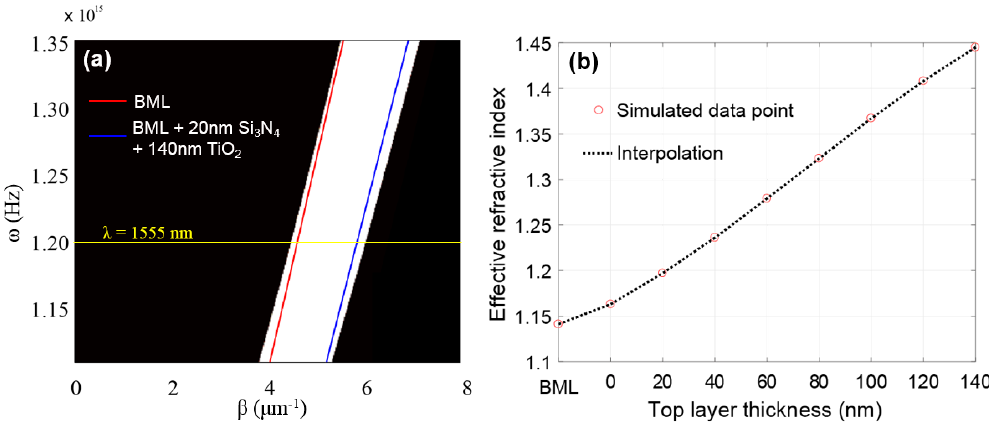
Figure 5. ( a ) Band-gap diagram and dispersion curves, obtained by TMM. The clear area is the localized photonic band-gap. The dispersion curve of the BML indicates the lowest effect index, n = 1.141 at λ = 1555 nm. Adding the defect layer and the top device layer moves the dispersion curve towards the right-side band edge, where the larger wavenumber indicates the larger effective index; ( b ) The relation between the thickness of the top layer and the effective refractive index at λ = 1555 nm. The maximum index contrast equals approximately